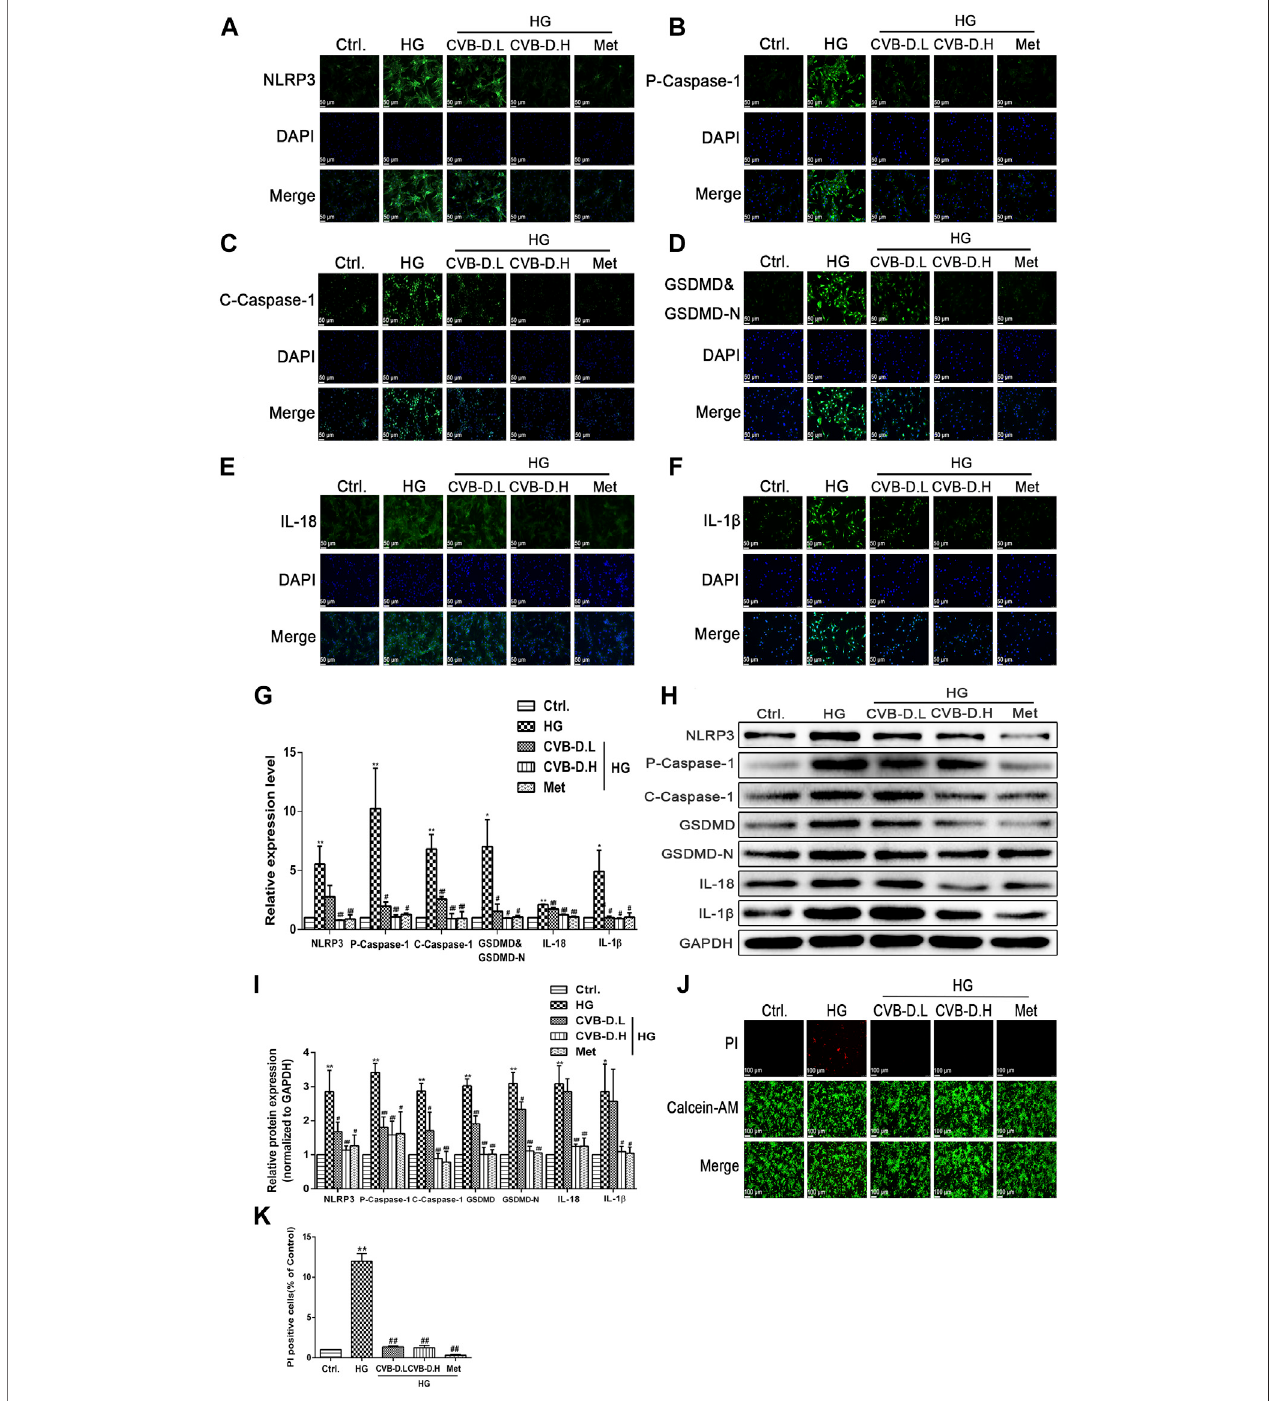
FIGURE 6 | CVB-D inhibits PNRCMs pyroptosis induced by HG. (A – F) The effect of CVB-D on the expression of pyroptosis pathway proteins was observed by immuno fl uorescence. (G) The fl uorescencevaluesofeachgroupwerecountedbyImageJsoftware. (H,I) Westernblottingwasusedtodeterminetheexpressionlevelof pyroptosis related proteins after CVB-D treatment. (J,K) Pyroptosis and living cells were differentiated by Calcein-AM/PI staining after CVB-D treatment. The data are presented as the mean ± SEM ( n = 3), * p < 0.05, ** p < 0.01 versus the control group; # p < 0.05, ## p < 0.01 versus the model group.